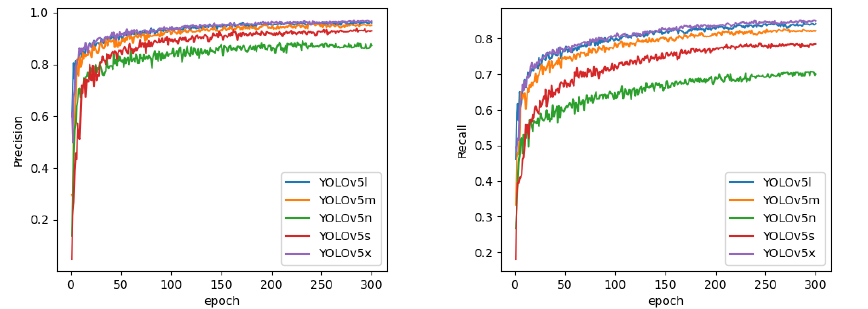
Figure 5. The variation trend of precision ( left ) and recall ( right ) during training. Table 1. Performance of different models on the RTX 2070